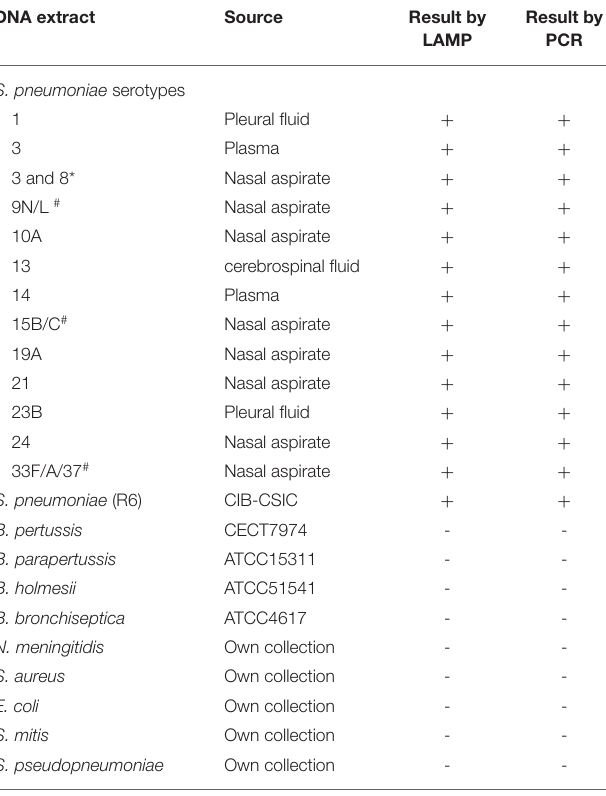
TABLE 1 | Quality control panel performed with DNA extracts from direct clinical samples and bacterial strains. DNA extract